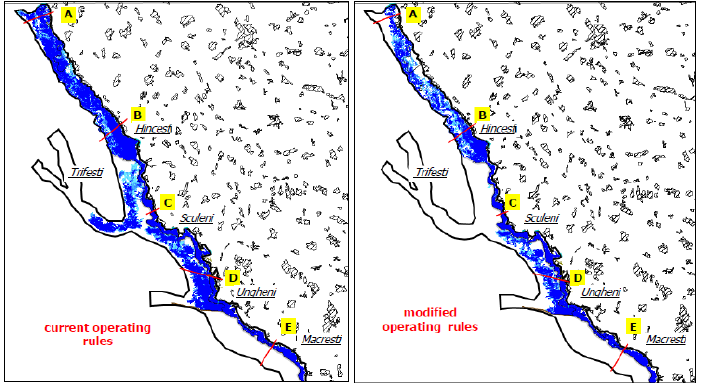
Figure 10. Increasing the flood storage through modifies Costești - Stânca management